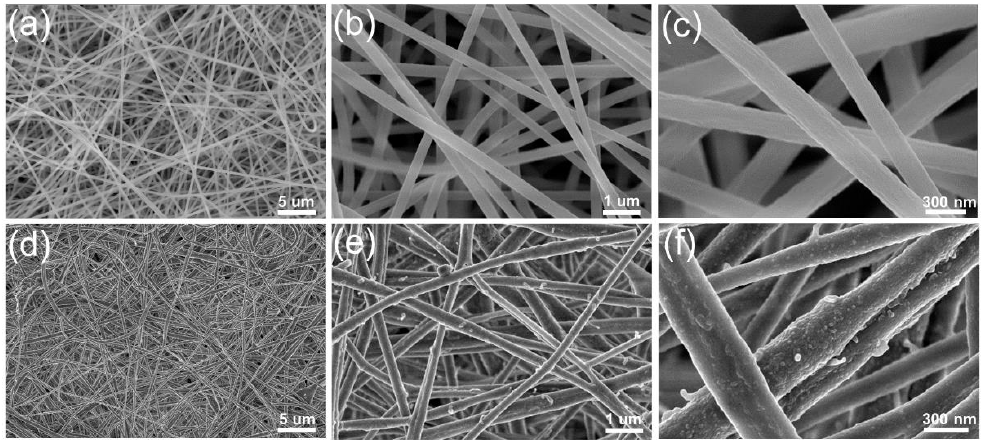
Figure 1. Scanning electron microscopy (SEM) images of the PAN NFM ( a – c ) and PAN-MIL101(Fe)- NH 2 NFM ( d – f ).